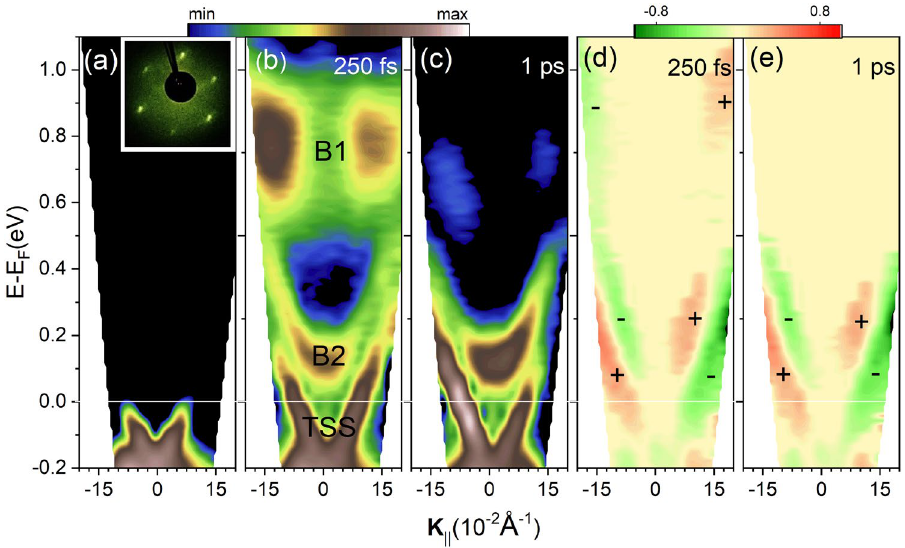
Figure 1. ( a )–( c ) TrARPES maps of Bi 2 Te 3 along the ¯ Ŵ ¯ K for selected pump-probe delays: ( a ) negative (unperturbed), ( b ) + 0.25 ps, ( c ) + 1 ps. Inset ( a ) shows the LEED pattern. Panels ( d ) and ( e ) show the